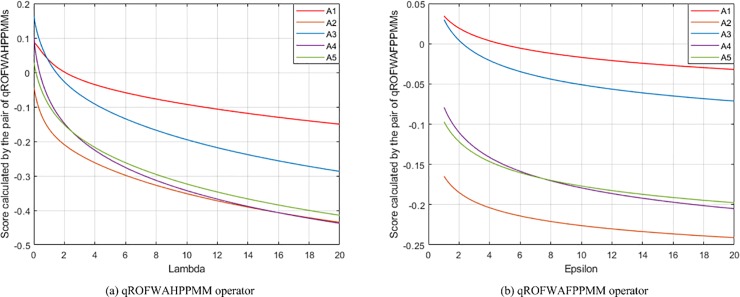
The results of Experiment 3.